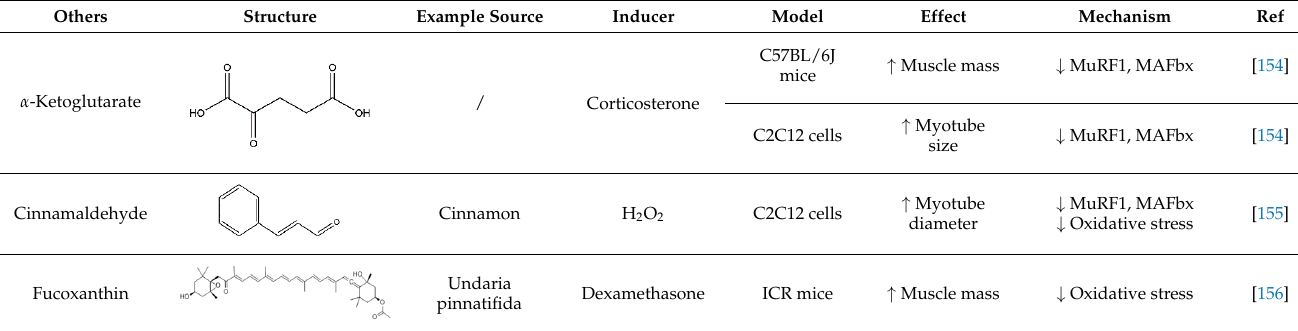
Table 10. Other phytochemicals in the prevention of the muscle atrophy in vitro/vivo.